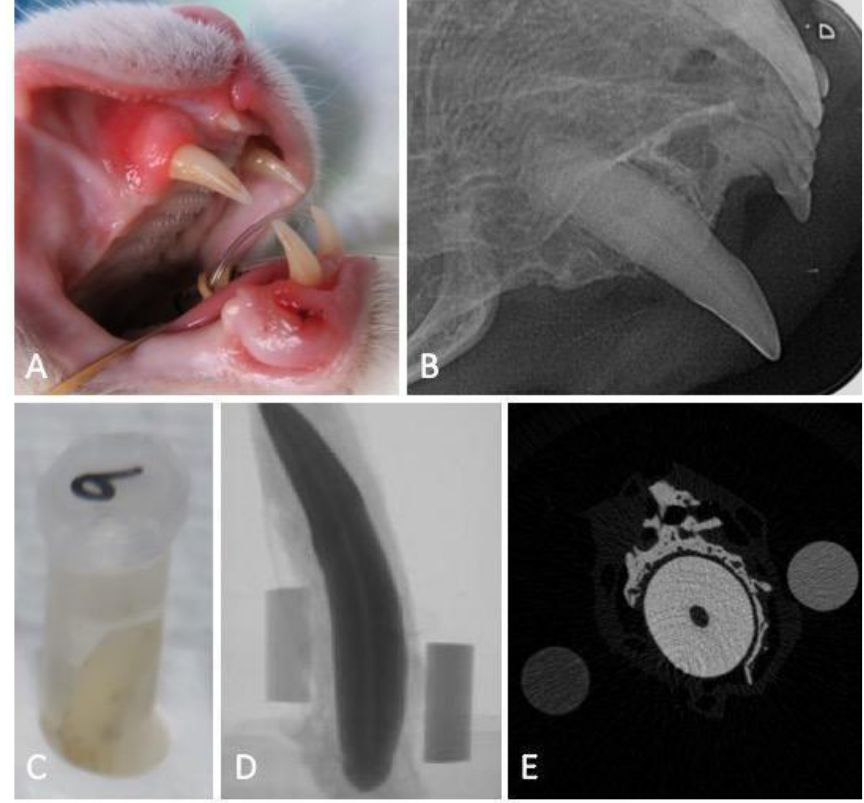
Figure 1. Flowchart of the experimental work: macroscopic image of a maxillary canine tooth ob- tained during the clinical examination before extraction ( A ), the respective intraoral dental radiograph revealing no signs of tooth resorption ( B ), sample storage ( C ) and micro-computed tomography projection ( D ) and transversal cut at the tooth root level ( E ), accompanied with the 0.25 and 0.75 g of HAp.cm −3 phantoms.